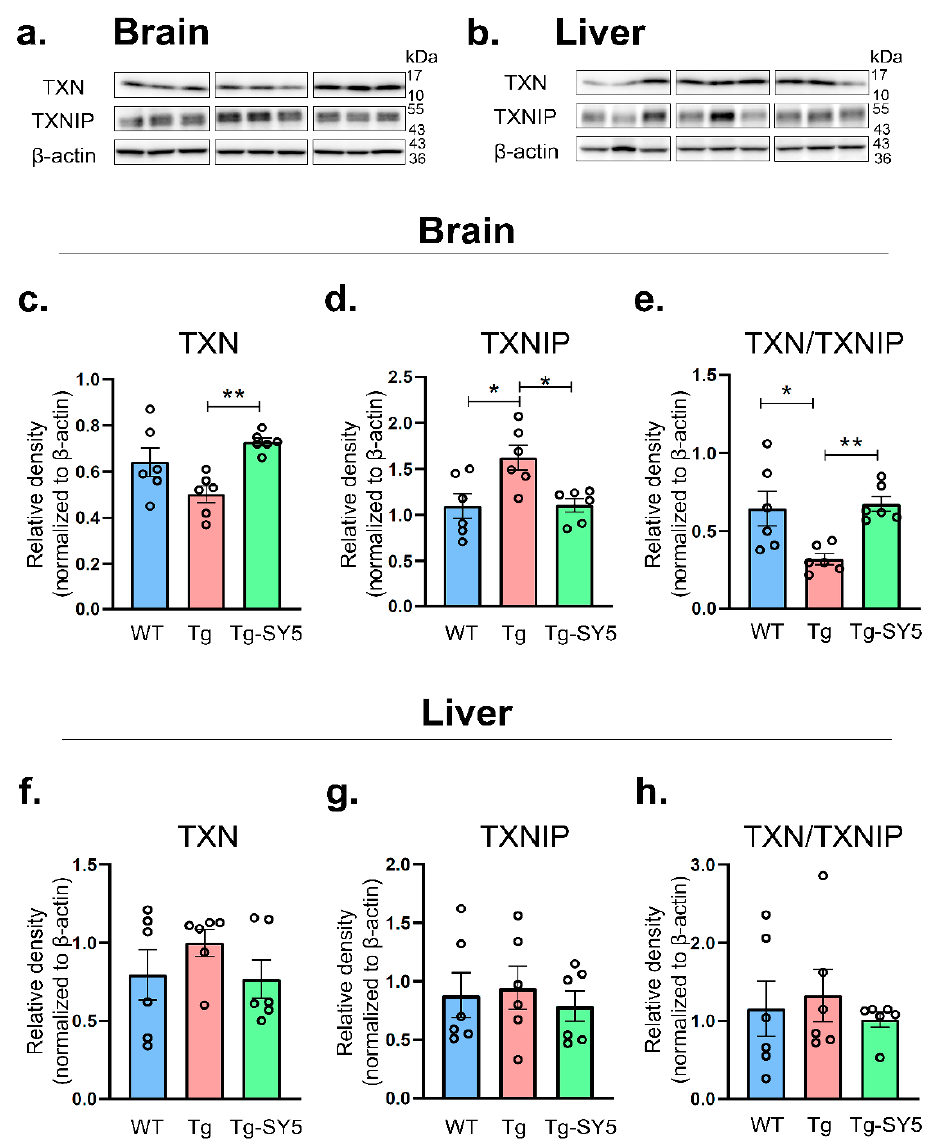
Figure 3. The TXN or TXNIP protein expression level in the APP/PS1 mice. Representative images of Western blotting for TXN, TXNIP, and β -actin in ( a ) the brain and ( b ) liver. Densitometric analysis of TXN or TXNIP and calculation of the ratio of TXN/TXNIP in the cerebral cortex of the brain ( c – e ) and the liver ( f – h ). Data are presented as mean ± SEM ( n = 6). Significance: ** p < 0.01, * p < 0.05. Full-length blots are presented in Supplementary Figures S1 and S2.